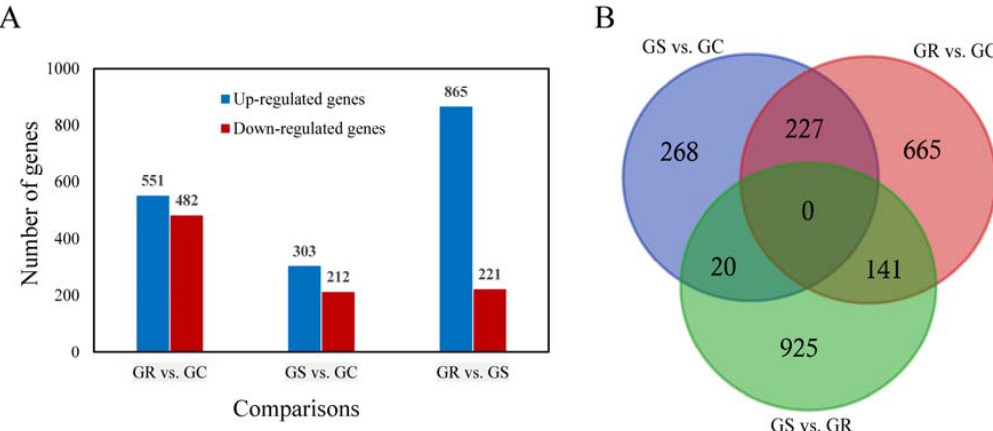
Figure 1. Scatter plots of the differentially expressed genes in GS vs. GC ( A ), GR vs. GC ( B ) and GR vs. GS ( C ). The blue scatters indicate the downregulated genes, and the red scatters indicate the upregulated genes.